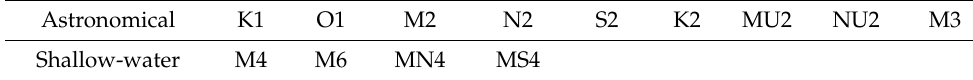
Table 2. Constituents included in the tide gauge